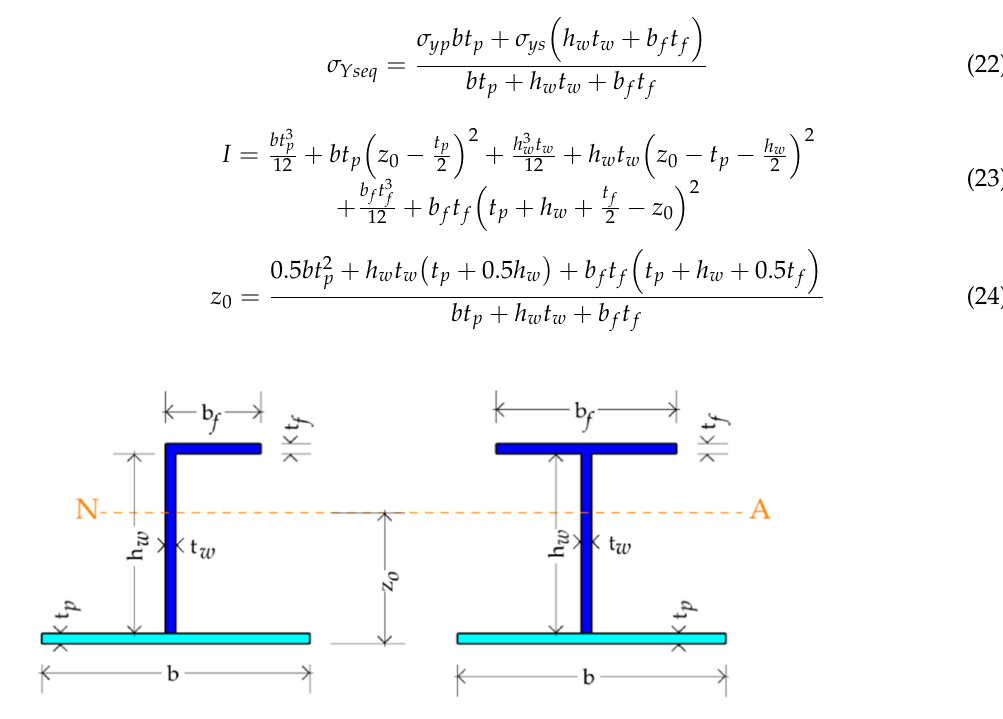
Figure 6. Cross-sections of the angle and T bars with attached plates.